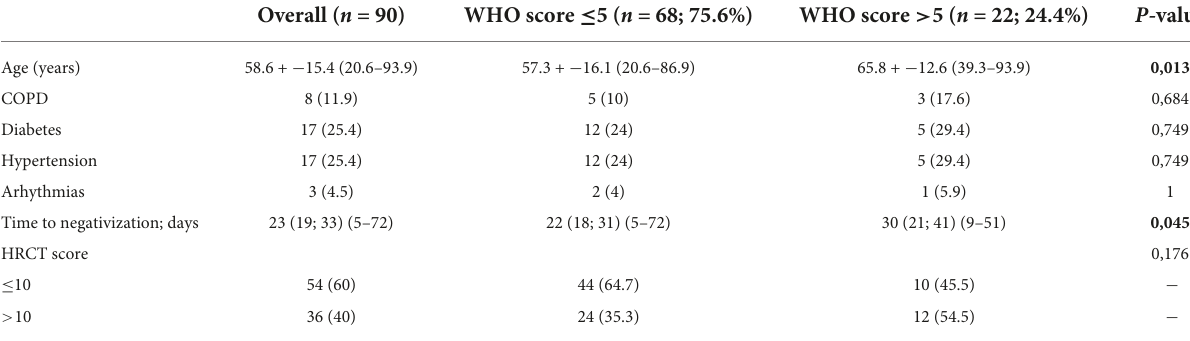
TABLE 1 Clinical and demographical characteristics of the study cohort stratified according to the World Health Organization (WHO) score at baseline.